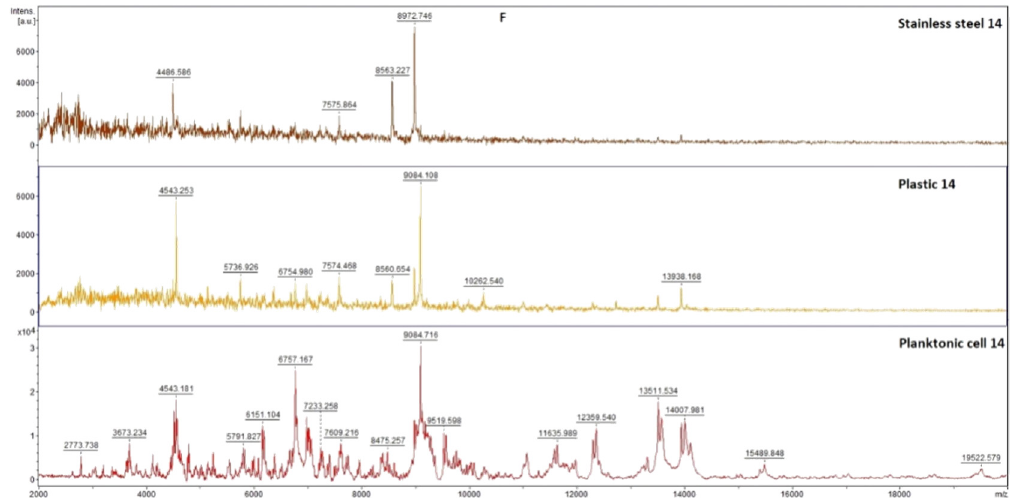
Figure 5. MALDI-TOF mass spectra of P. fluorescens during biofilm development: ( A ) 3rd day, ( B ) 5th day, ( C ) 7th day, ( D ) 9th day, ( E ) 12th day, and ( F ) 14th day.